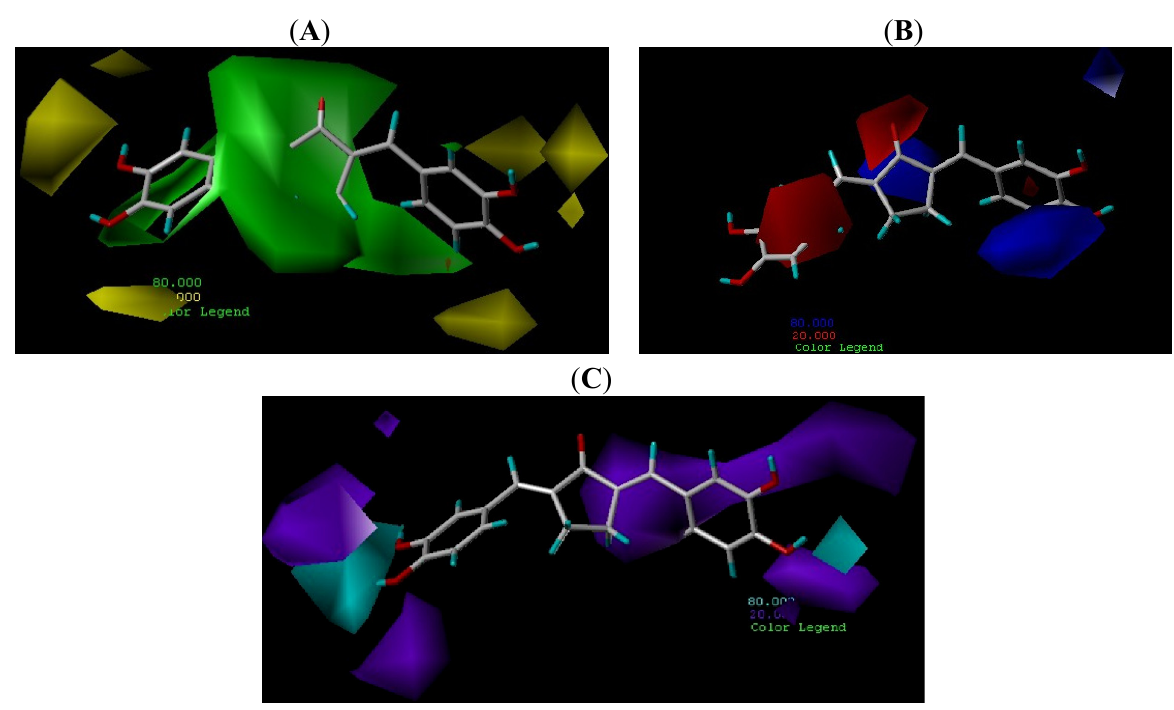
Figure 5. The binding mode between compound 6 with ALDH1 ( A ). Active site MOLCAD surface representation Liphilic potential ( B ) and Hydrogen Bonding ( C ); ( B ) Brown: Hydrogen and green: Hydrophlic; ( C ) Red: Hydrogen donor and blue: Hydrogen